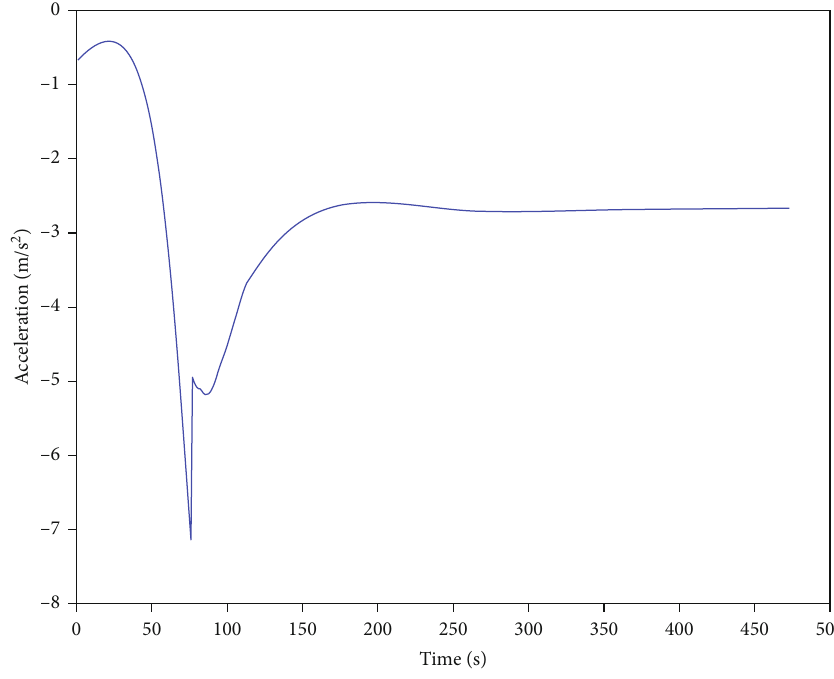
Figure 3: The acceleration curve of a HGV.